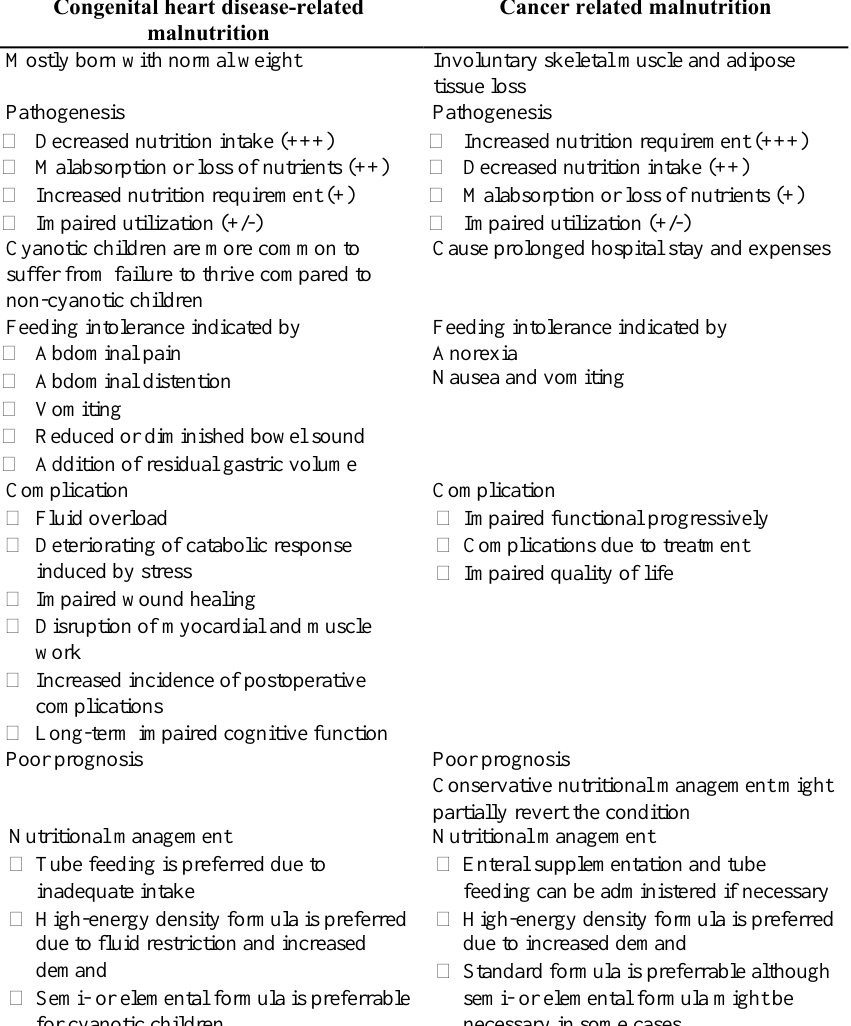
Table 1. Difference between disease-related malnutrition in children with congenital heart disease and cancers